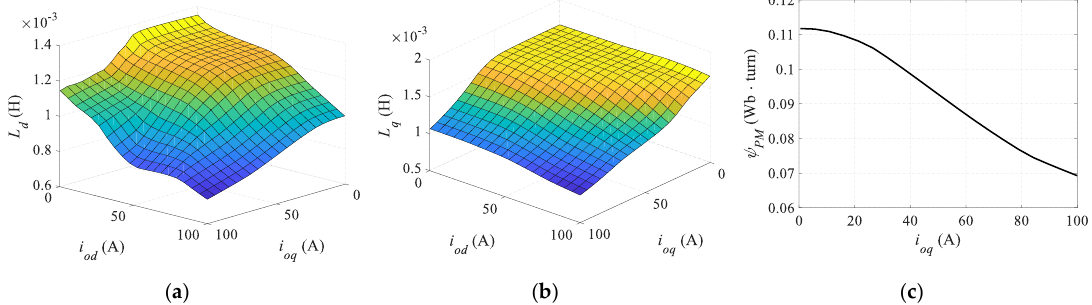
Figure 15. Optimized solution's induction coefficients (a) 𝐿 𝑑 , (b) 𝐿 𝑞 , and (c) permanent magnet linked flux 𝛹 𝑃𝑀 . The torque map is estimated from these with (5) limited to the optimum torque producing current density 𝐽 𝑜𝑞 = 6.99 MA/m 2 (I = 33 A) , corresponding to the required 20 Nm, Figure 16a. In this case, the efficiency map, Figure 16b is obtained for the operation points following the maximum torque per ampere (MTPA) strategy from (3) – (7). These points are presented in Figure 16a representing the constant torque and field weakening regions. The MTPA trajectory on the constant torque region shows small I d = 5A at 20 Nm, meaning that reluctance torque is not a considerable component. This stems from the optimization being based on the maximization of the electromagnetic torque component. As seen in Figure 16b the field weakening region occurs from 8000 rpm onwards.